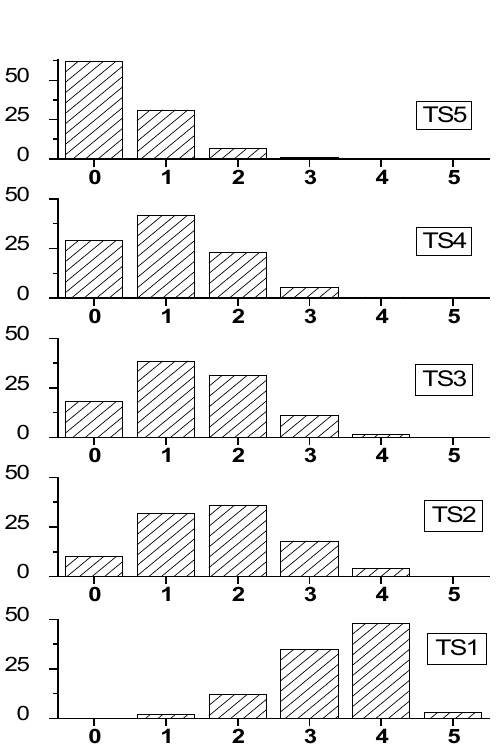
) for fraction HB